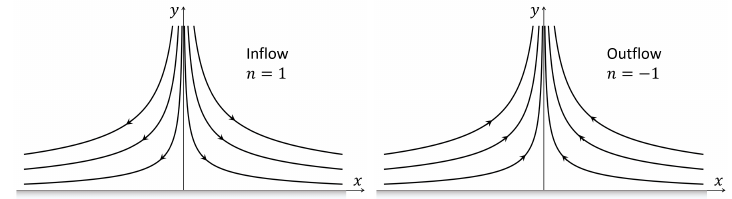
Figure 4. Sketch of velocity field in a near-wall stagnation-point